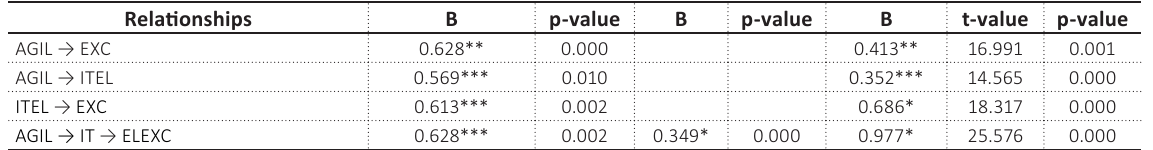
Table 3. Results of hypotheses testing Relationships Β